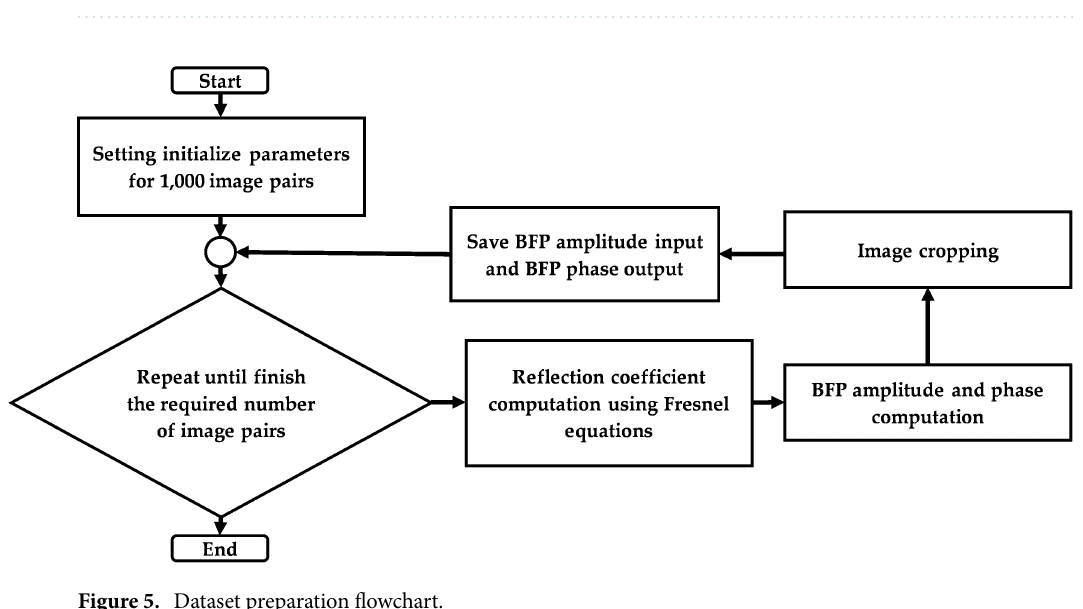
Figure 5. Dataset preparation